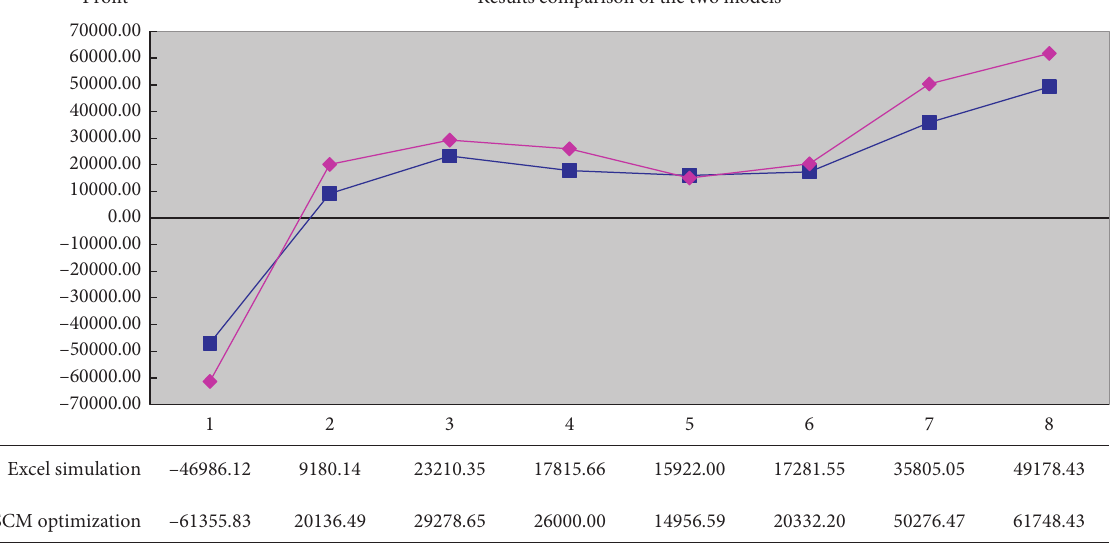
Figure 6: The results of the GAMS